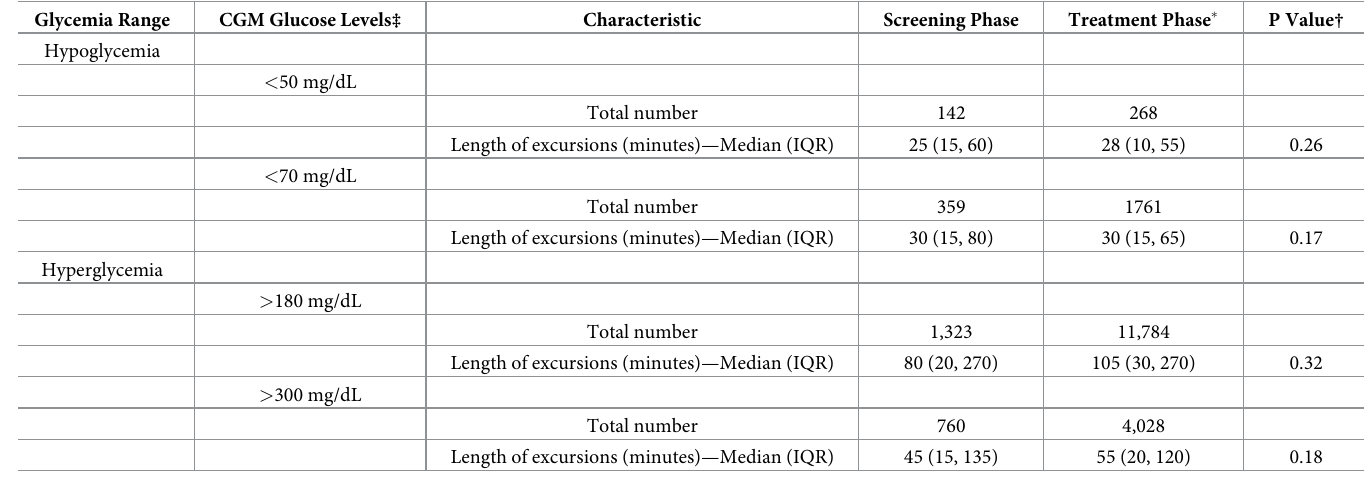
Table 5. Characteristics of glycemic